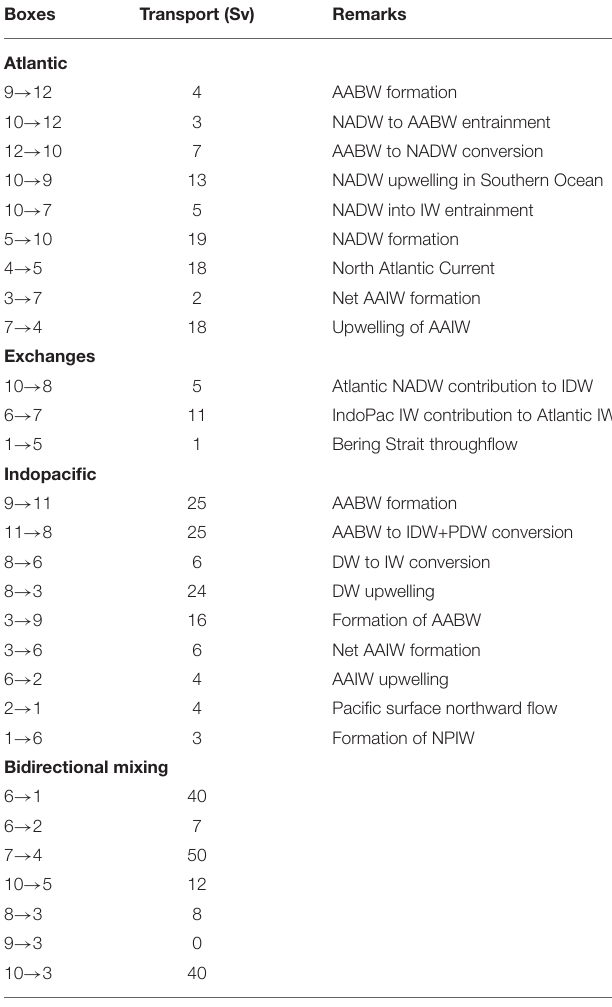
TABLE 2 | Advective fluxes between the model boxes, and their relation to water mass transformation rates. Boxes Transport (Sv)